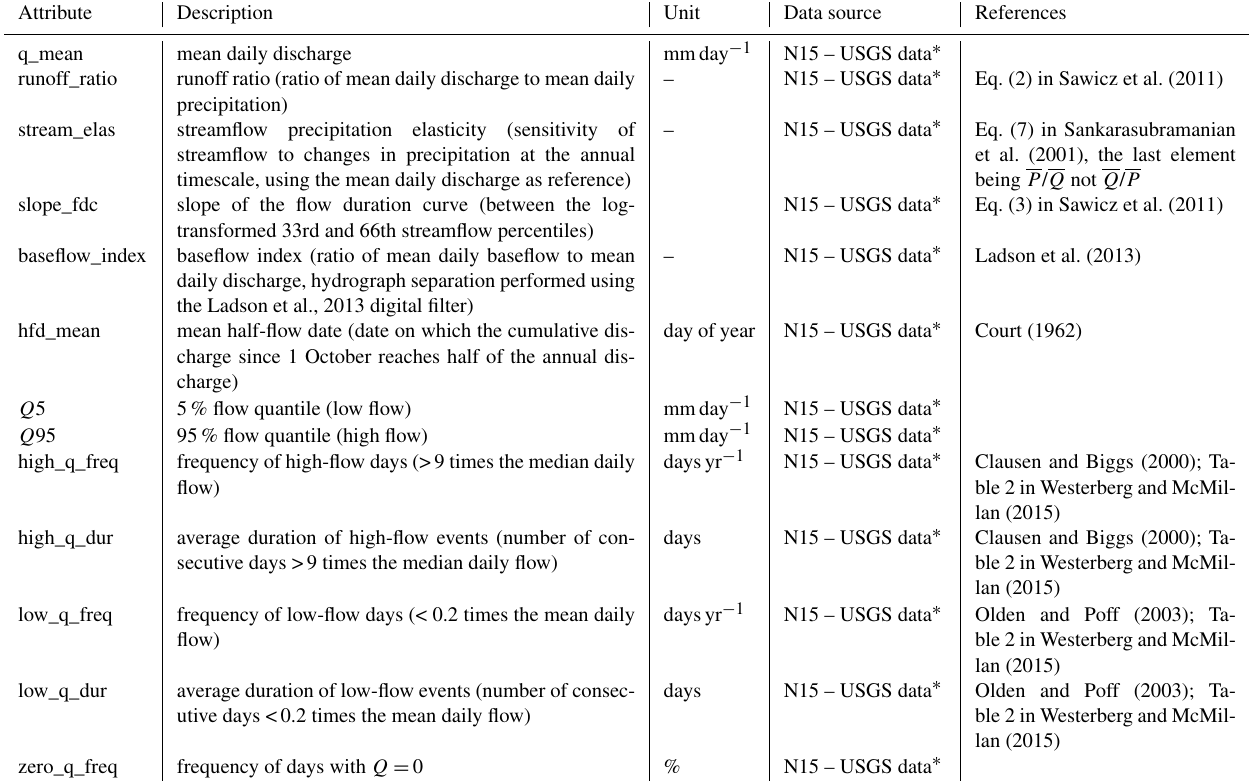
Table 3. Hydrological